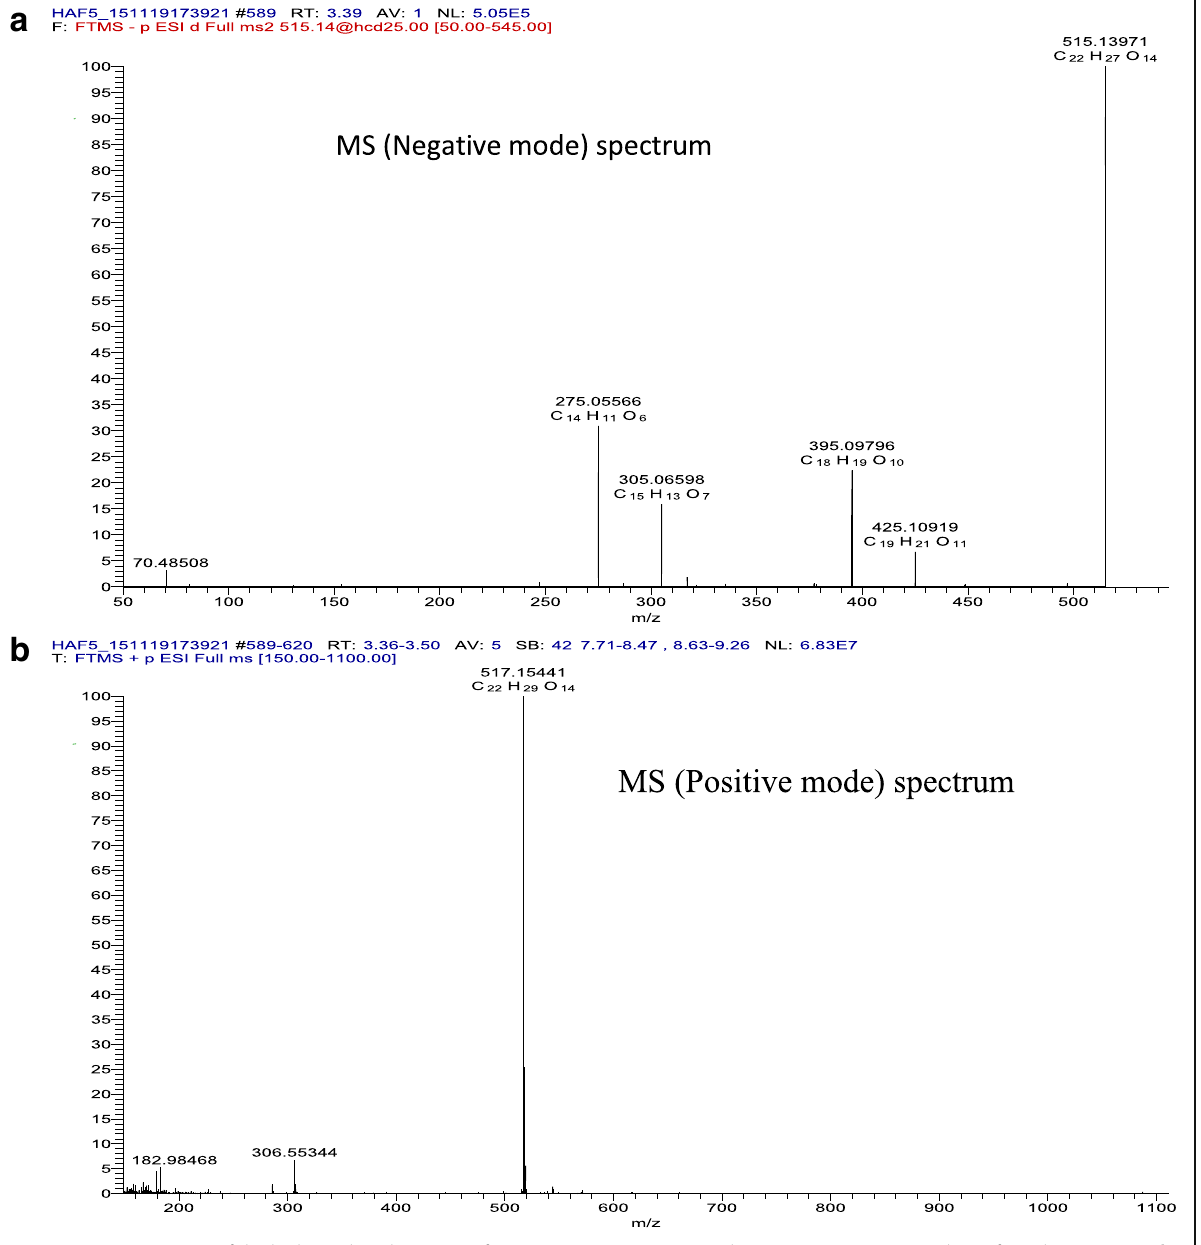
Fig. 3 Mass spectrometry of the hydromethanolic extract of F. sycomorus. a : negative mode (Unitary mass 515, 14 g; brute formula: C 22 H 27 O 14 ); b : positive mode ( Unitary mass 517, 15 g; brute formula: C 22 H 29 O 14